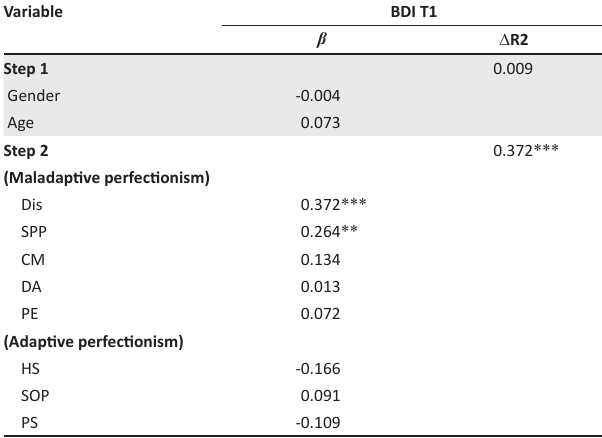
standards; SOP, self-oriented perfectionism; PS, personal